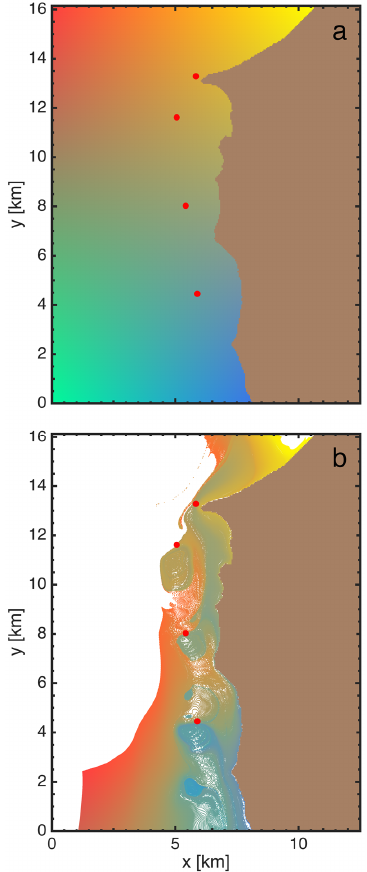
Figure 2. The initial ( a ) and ( b ) final positions for the transport of an initially uniform dense coverage of uniquely colored particles across the Coral Bay region over a half-day period. The final configuration visually suggests the presence of key transport features, although the nature of the underlying flow structures remains unclear. Red dots indicate the central location of channels, as in Figure 1. Underlying the flow transport in Figure 2a,b are the LCS, and in the background of Figure 3a,b we show the forward-time (repelling) and backward-time (attracting) FTLE fields, respectively. Superimposed on top of these FTLE fields, we identify the repelling hyperbolic coherent structures (orange lines; Figure 3a), the attracting hyperbolic coherent structures (orange lines; Figure 3b), and the elliptic coherent structures (yellow lines; Figure 3a,b). In all cases, these align with the FTLE ridges (although this alignment is not a strict requirement). The elliptic LCS enclose material that remains